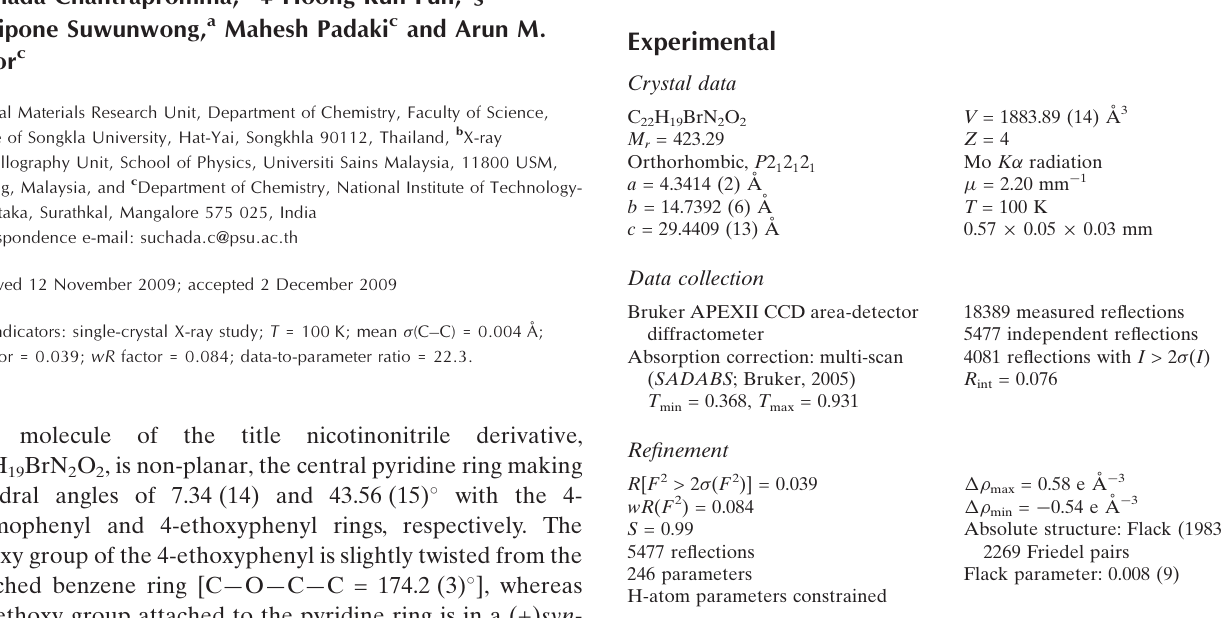
nicotinonitrile derivative,